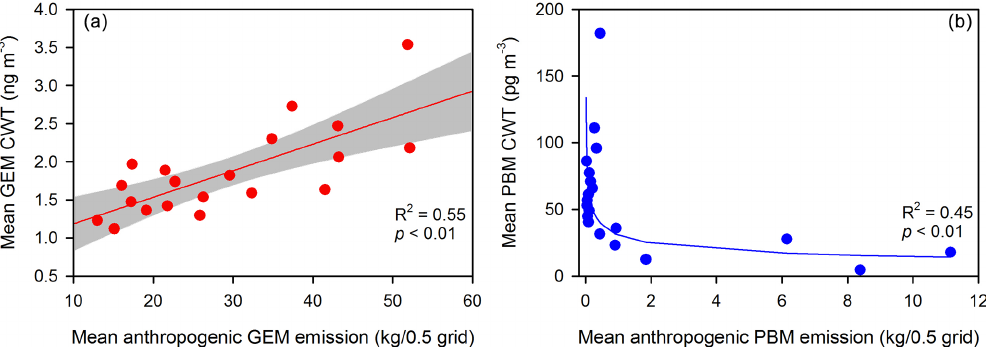
Figure 6. Correlation between the simulated GEM or PBM CWT value and their respective anthropogenic emissions (AMAP/UNEP, 2018). The location of each gridded CWT value is matched with that of anthropogenic emission. Gridded anthropogenic emissions are divided into 20 groups with an equal number of grids, starting from the lowest to highest emission